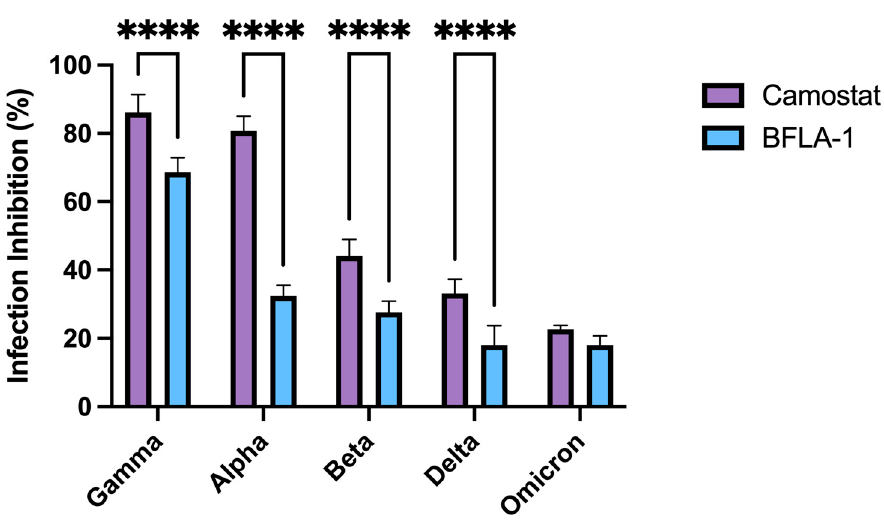
Figure 4. The two entry pathways differently exploited by SARS-CoV-2 viral variants to infect Calu-3 cells. Graph showing the BFLA-1 and camostat mesylate inhibitory activity against VOCs: Alpha, Beta, Gamma, Delta and Omicron. Cells were pre-treated 1 h before the infection, and the cell supernatants were collected at 72 h. Each condition was tested in triplicate, and the results were normalized over controls. The infection inhibition percentages were reported as the mean values ± SD, **** p < 0.0001.